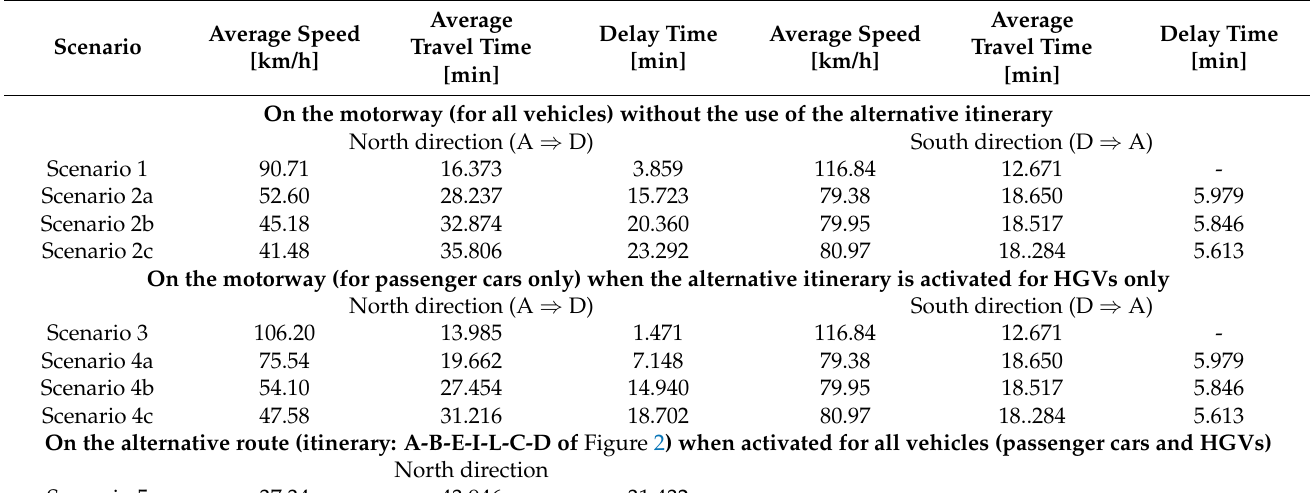
Table 6. Simulation results: average speed, average travel time, and delay time for the scenarios investigated when the north tube is partially or completely closed for 3 h (for example: Scenario 2c, delay time on the motorway for all vehicles = 35.806 − 12.514 = 23.292 min; Scenario 4c, delay time on the motorway for passenger cars only = 31.216 − 12.514 = 18.702 min; Scenario 5, delay time on the alternative itinerary for all vehicles = 43.946 − 12.514 = 31.432